Question: Draft a figure caption describing what is shown.
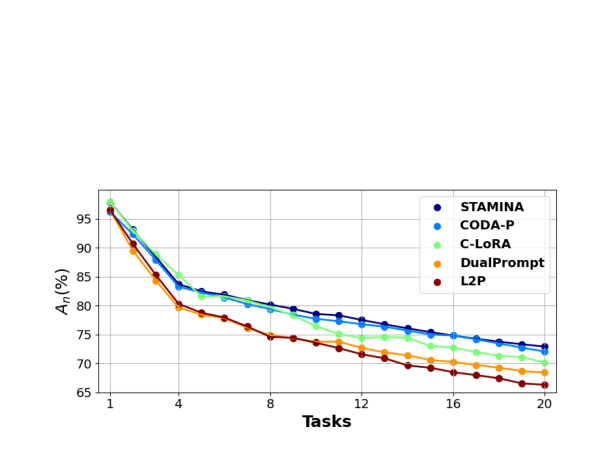
Answer: Image classification results on ImageNet-R [39, 62]. An gives the accuracy averaged over all seen tasks.